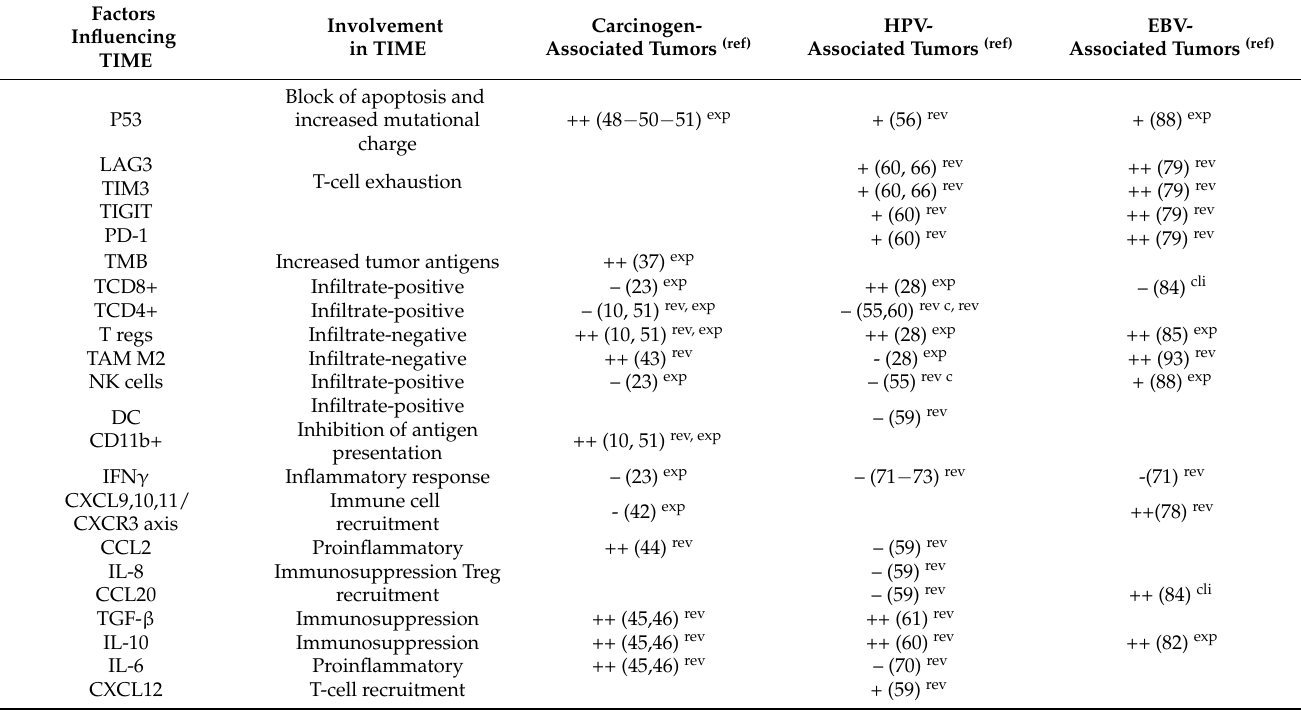
Table 1. Factors influencing TIME: difference between carcinogen-associated and virus-associated